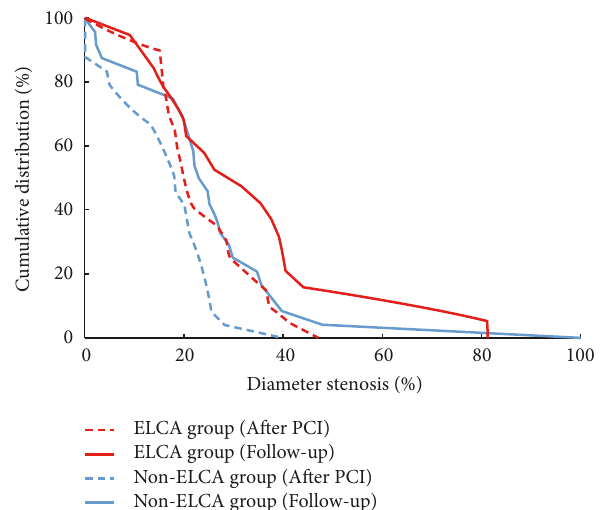
Figure 2: Cumulative distribution curves of diameter stenosis imme- diately after percutaneous coronary intervention procedure and at follow-up angiography. Percent diameter stenosis after PCI was significantly higherin theELCA group than in thenon-ELCA group (p=0.02),buttherewasnosignificantdifferencebetweenthegroups at follow-up (p = 0.21). ELCA, excimer laser coronary atherectomy; PCI, percutaneous coronary intervention.